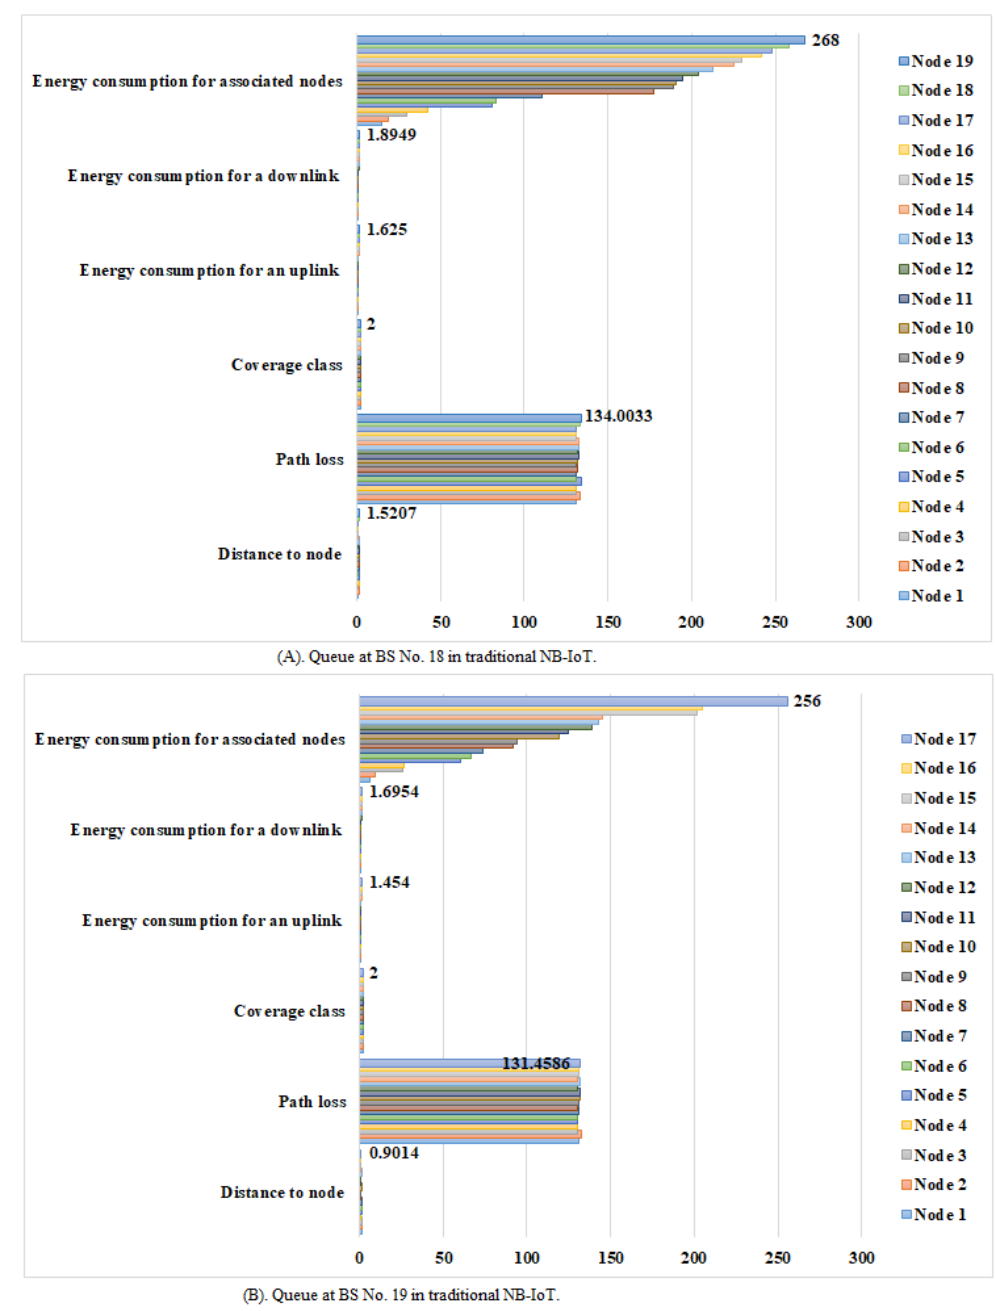
Figure 26. Queue at BSs No. 18 and No. 19 in a traditional